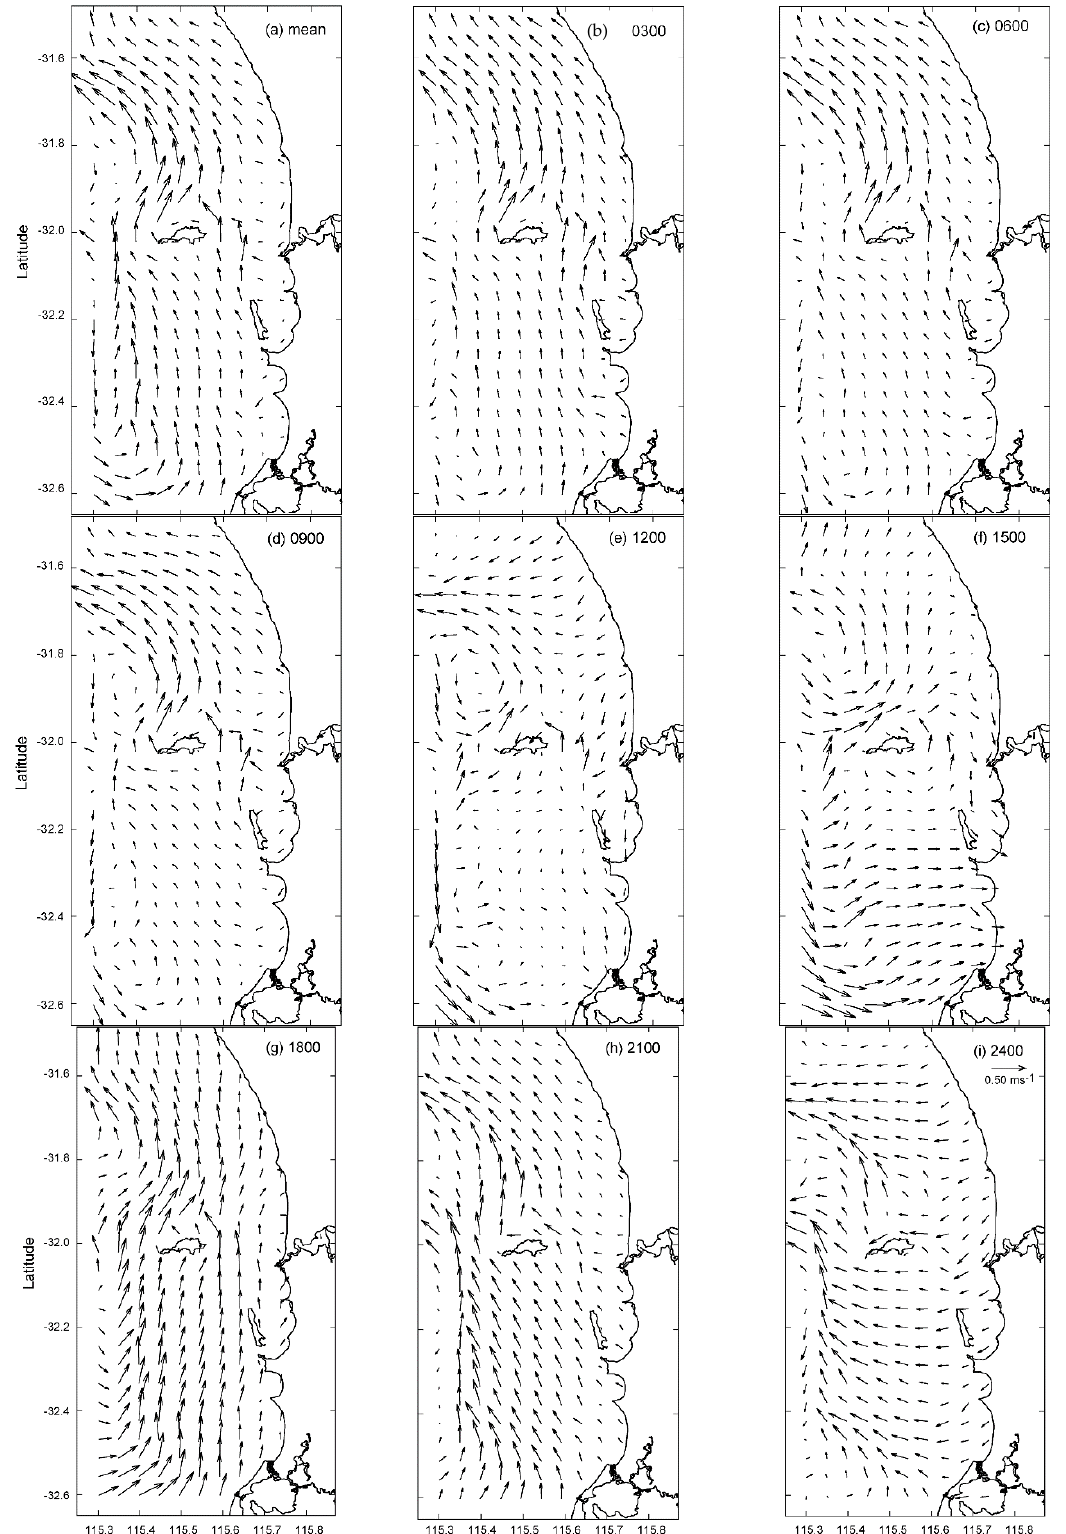
Figure 15. Surface ocean currents in the study region over a diurnal cycle on 23 February 2017 from the ROMS model. ( a ) mean over 24 h; and ( b – i ) current vectors at 3 hourly intervals. Note the velocity scale for all plots are shown on ( i ).